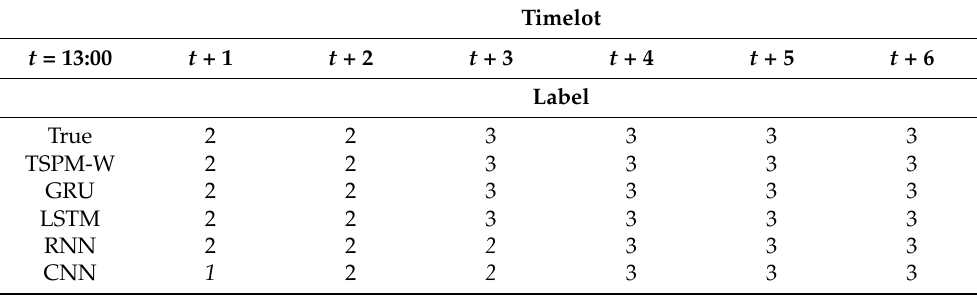
Table 9. Traffic situations’ prediction (Feature combination 1) for 5th November 2018 13:00 to